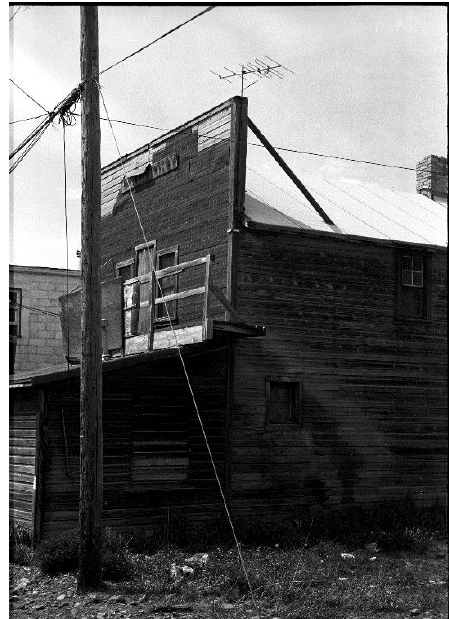
Figure 1: Partial south (front) and east facades, with brick chimney, Insulbrick cladding, shed addition & wood balcony, 1973. Source: